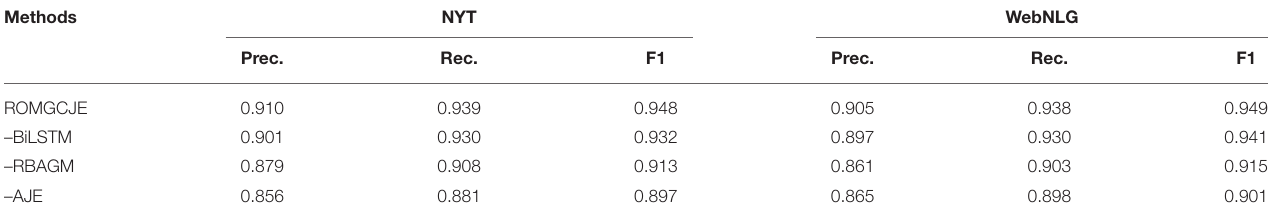
TABLE 4 | Ablation studies of ROMGCJE on NYT and WebNLG dataset. Methods NYT WebNLG Prec. Rec. F1 Prec. Rec.